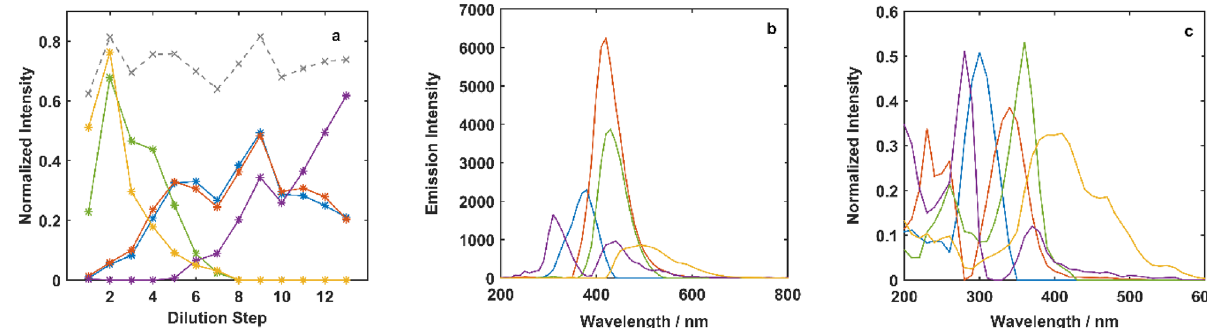
Figure 2. Calculated relative intensities during dilution ( a ), in addition to emission ( b ) and excitation ( c ) profiles obtained from the application of PARAFAC (98.4% explained variance) with five factors on the data from the dilution process. The gray dashed line in part ( a ) shows the normalized total variation of EEM in dilution The chromatogram of thirty-three elution samples (Fig. 1a) reveals that CNDs fractions with different surface charges mainly contain different fluorophores. The dominating fluorophores in initial and last elution samples are the F3 and F4, which are located on the most positive and the most negative dots, respectively. CNDs containing F1 fluorophores (B and D) have more positive sites compared to dots with F2 fluorophores (C and E). The overall order of net negative charges on the surface of CNDs, regarding their fluorophore contents, could be considered as CND-F4 > CND-F2 > CND-F1 > CND-F3. Particles in A fraction with low retention time are mostly the F3 containing dots with almost the lowest negative surface charge, compared to other particles. Also, it seems that the small contribution of F4 in A fraction leads to the small number of negative charges and low retention of this group of CNDs in the column. Fluorophore labels are not assigned as F + , F ++ , or F − because it is not certain